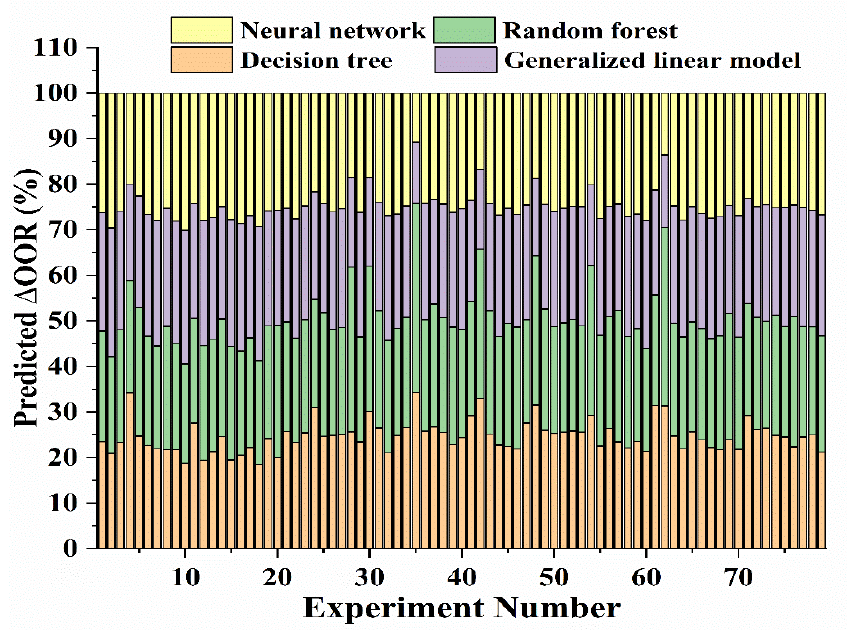
Figure 6. Predicted change in out-of-roundness measured by machine learning techniques.